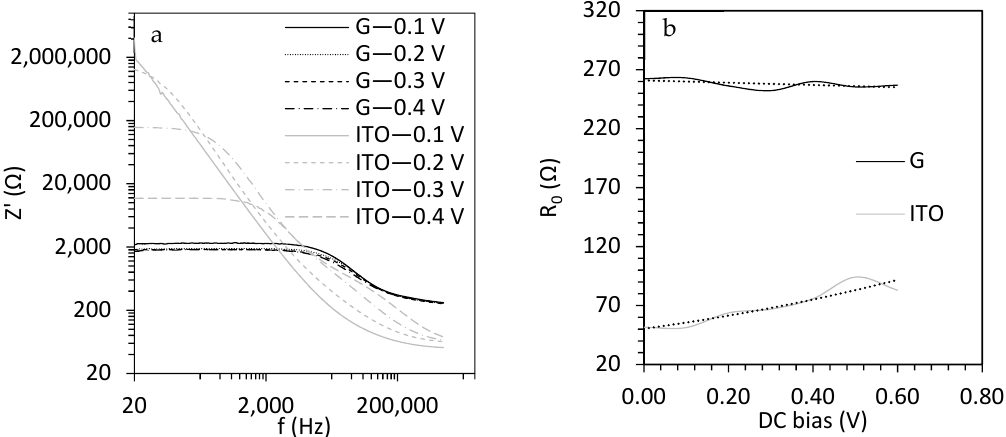
Figure 7. ( a ) Dispersion of total real part resistance of impedance versus frequency for OPVs based on graphene and ITO as window electrodes, and ( b ) the linear J variations vs. V for graphene-based device, and ITO-based OPV device.